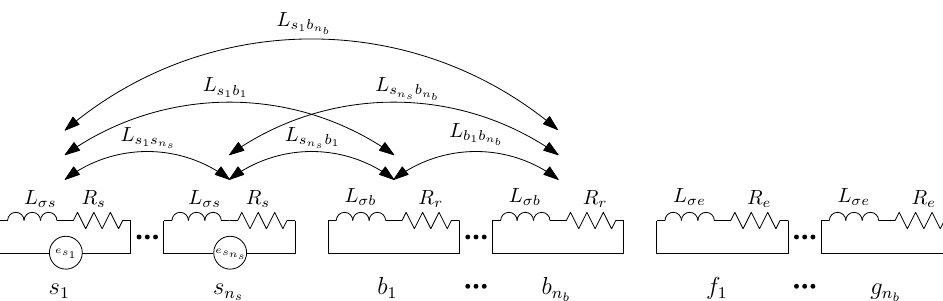
Figure 4. Primitive IM network, found by removing all interconnections between the windings and short circuiting each. The arrows show the mutual impedances between stator windings and cage bars. The end ring segments do not couple with the other windings through mutual